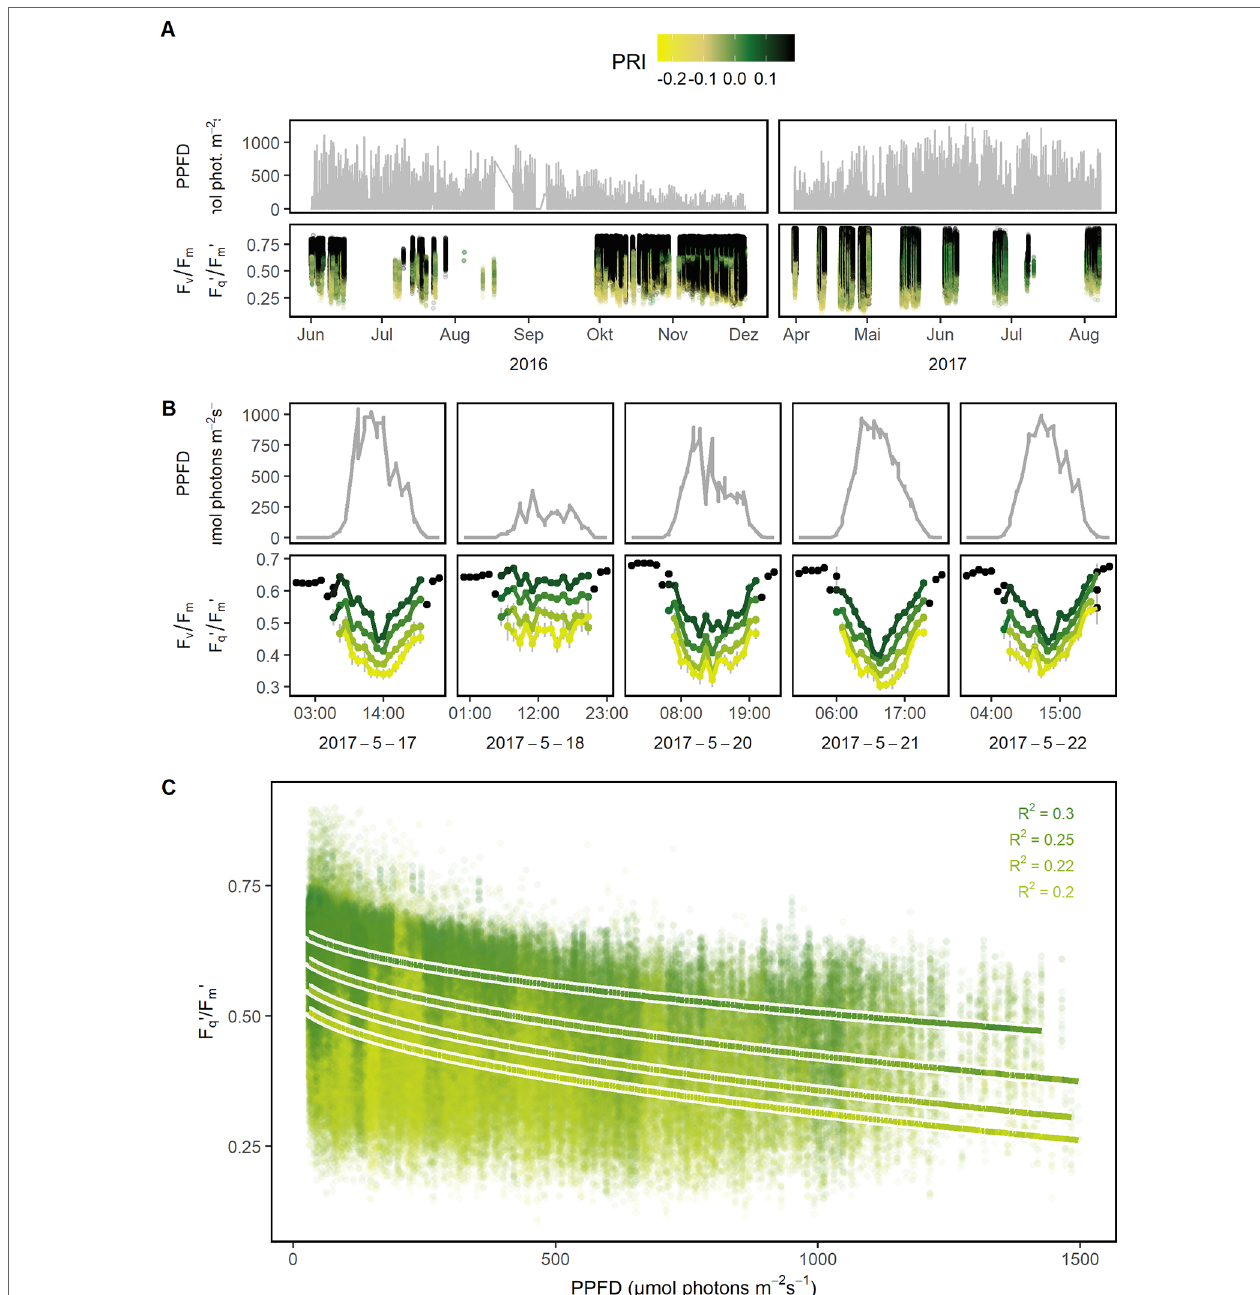
FIGURE 3 | Quantum efficiency of the photosystem II (F v /F m in the dark and F q '/F m ' in the light) of barley, maize, soybean, and wheat genotypes was monitored under a fluctuating environment over two seasons in high time resolution. (A) Natural fluctuation of photosynthetic photon flux density (PPFD) together with the dynamic F v /F m and F q '/F m ' and their associated photochemical reflectance index (PRI) values are shown over the two growing seasons (n = 782,420, acquired from May 2016 to August 2017). (B) PPFD and F v /F m (respective F q '/F m ') are shown in a subset of diurnal measurements within 1 week to illustrate the strong interaction between the parameters. F v /F m and F q '/F m ' were grouped according to photochemical reflectance index (PRI) levels to reveal the strong effect of PRI. Gray error bars show 95% confidence interval (n = 8 to 975 independent measurements averaged per PRI level and hour, 106,433 in total). (C) F q '/F m ' was correlated to PPFD, grouped according to PRI levels, and fitted to a linear model depending on PPFD (square root transformed, all measurements with associated PPFD > 25 μmol photons m −2 s −1 were used, n = 42,434 to 179,152 measurements per PRI group). Chlorophyll fluorescence and spectral data was acquired by an automated light-induced fluorescence transient (LIFT) device scanning over the crop canopy. PPFD was recorded every minute by three stations distributed in the unheated glasshouse and linked to LIFT measurements done in the same minute.